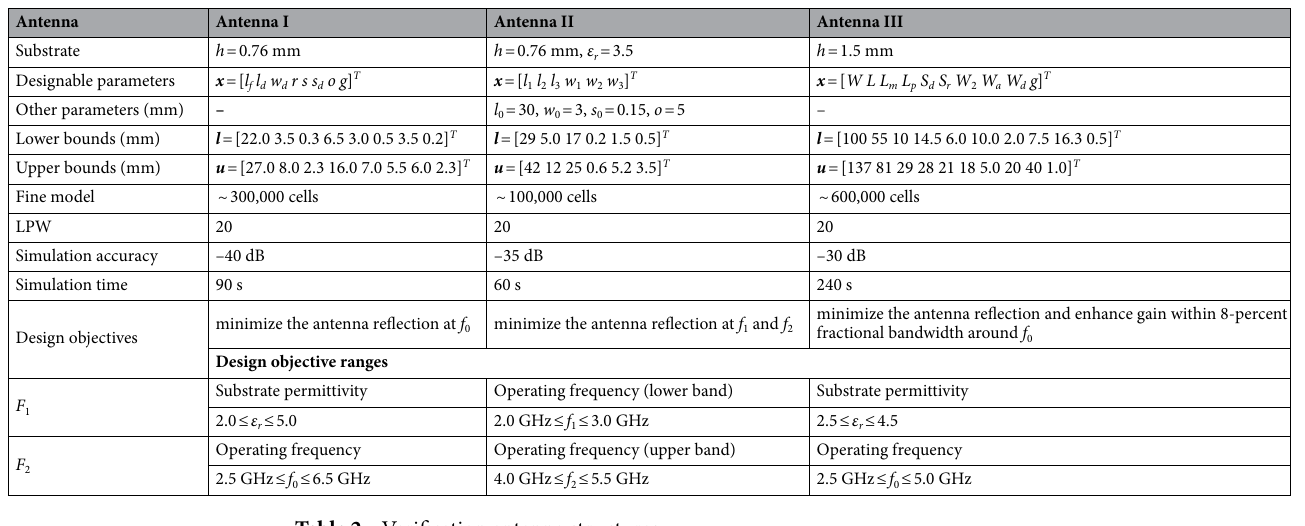
Table 2. Verification antenna structures.